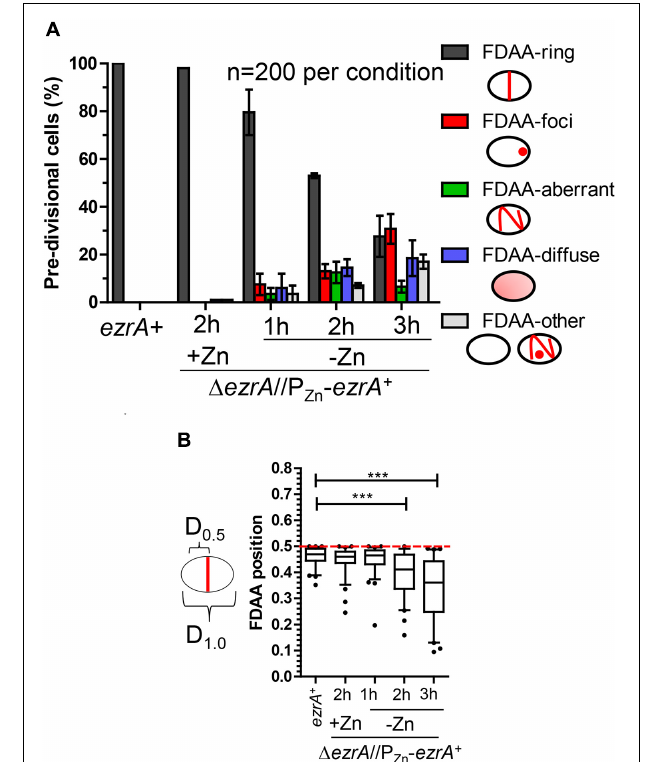
FIGURE 5 | Quantification of 2D-FDAA labeling patterns of EzrA depleted pre-divisional cells which were pulse-chase labeled. Strains used IU1945 (wild-type cells) and IU8799 ( (cid:49) ezrA// P Zn -ezrA + ). Cells were grown and labeled as described in Supplementary Figure 12A . (A) Categorical bar graph showing different labeling characteristics with the short-pulse FDAA (TADA). Average values are represented by the colored bars, and error bars are for a SD of two different biological replicates in which 100 cells were counted per experiment. (B) Box-and-whisker plots (whiskers, 5 and 95 percentile) showing the position of FDAA-rings relative to whole cell length were determined in cells which contained FDAA-rings in (A) . Red dotted line indicates D = 0.5, a precisely midcell measured Z-ring. p -values obtained with Mann–Whitney two-tailed unpaired t -test are for comparisons between ezrA + and other conditions. *** indicate p <